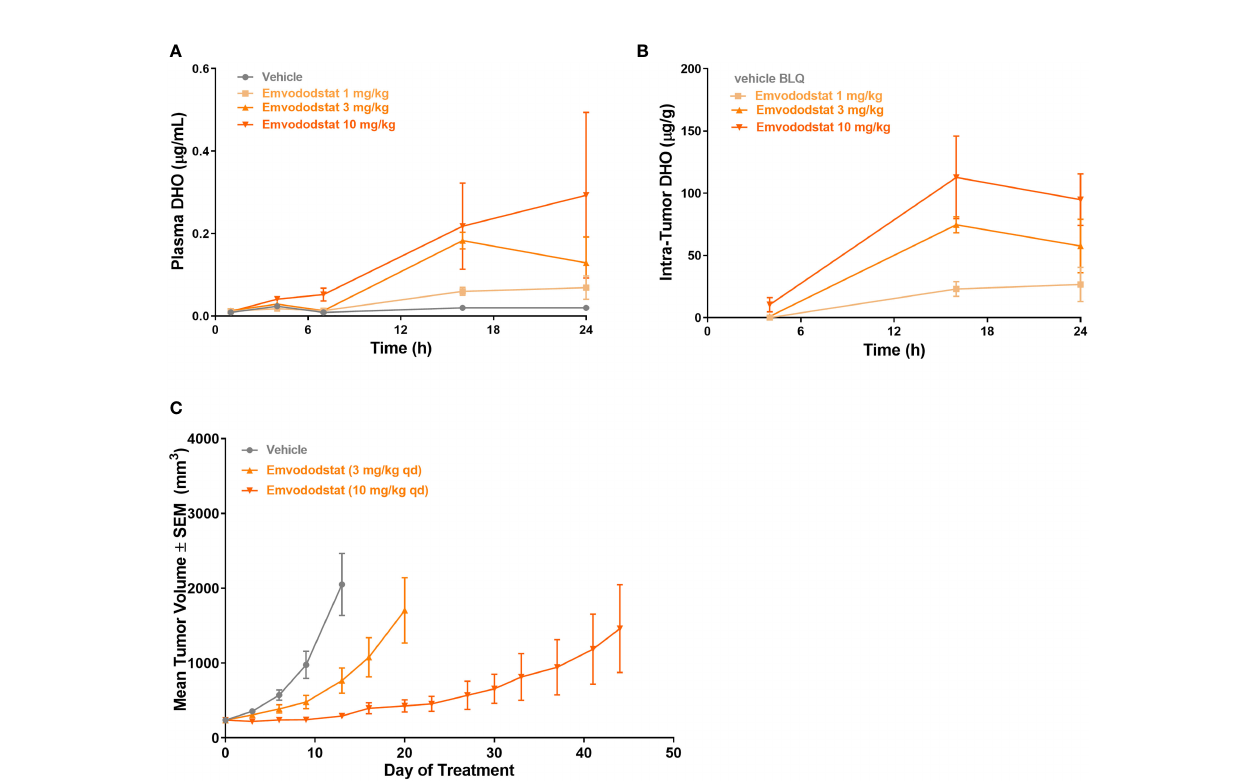
FIGURE 5 | Mice bearing MOLM-13 tumors were dosed with emvododstat and at each timepoint, 3 mice per group were euthanized. (A) plasma and (B) tumors in a mouse xenograft model. (C) MOLM-13 tumor growth. Values represent the mean ± SEM of 10